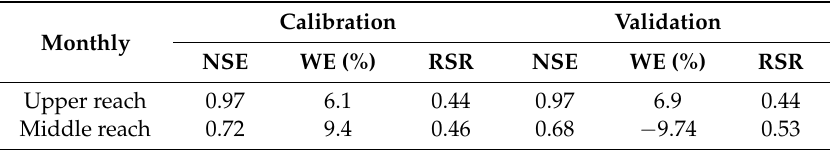
Figure 6. Monthly streamflow comparison between the simulations and observations in the calibration and validation periods of the upper reach at Yingluoxia station. Table 4. The statistical results of streamflow simulations of the upper and middle reaches.